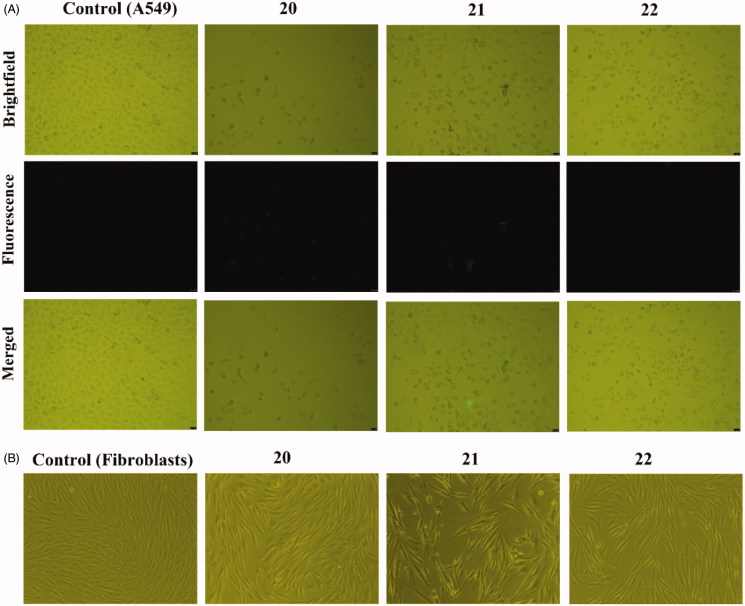
Intracellular accumulation after 24 h incubation of 20–22 in A549 cells (5 µM, A) visualized by fluorescence microscopy, and in fibroblasts (5 µM, B) visualized by phase contrast microscopy. Images were obtained by the fluorescence microscope Leica DMI6000B (HCX PL APO CS 10.0 × 0.40 DRY UV objective) and Leica DMI3000B. Presented images were obtained from three independent experiments.